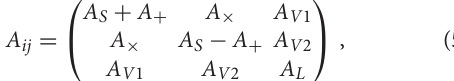
and . Other gravity theories might contain also a transverse (breathing) + ×